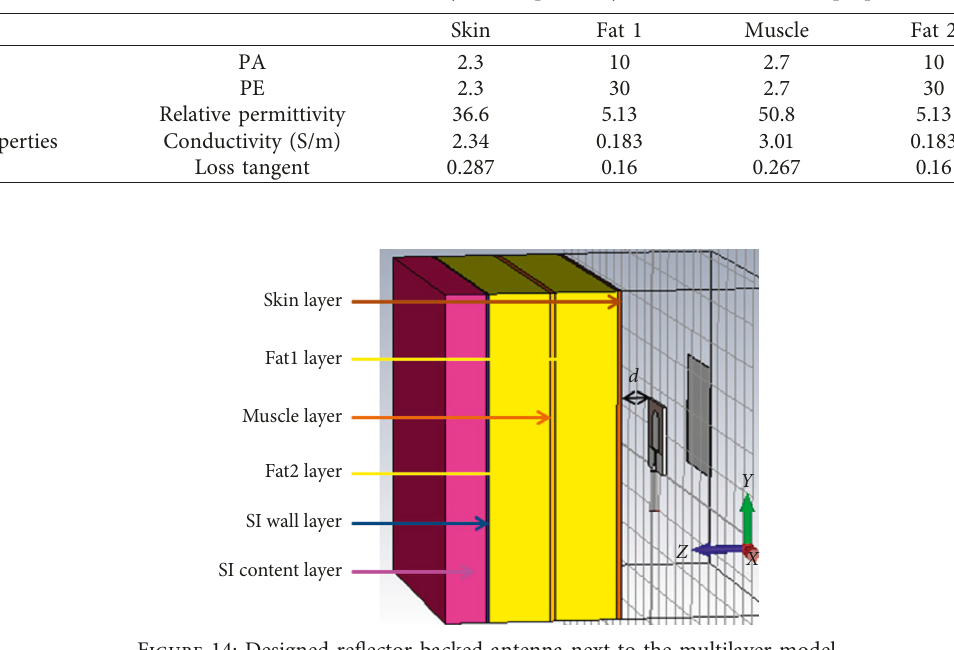
Table 5: Thicknesses in mm of human body tissues per study case and its dielectric properties.